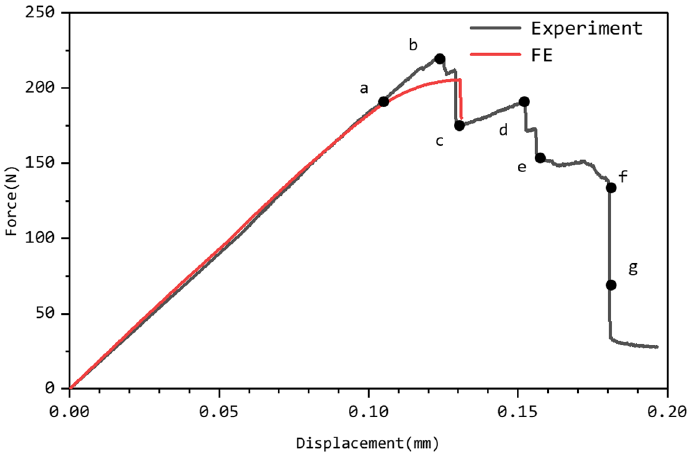
Figure 10. Experimental and computational force-deformation graphs for composite material under a three-point bending test. a three-point bending